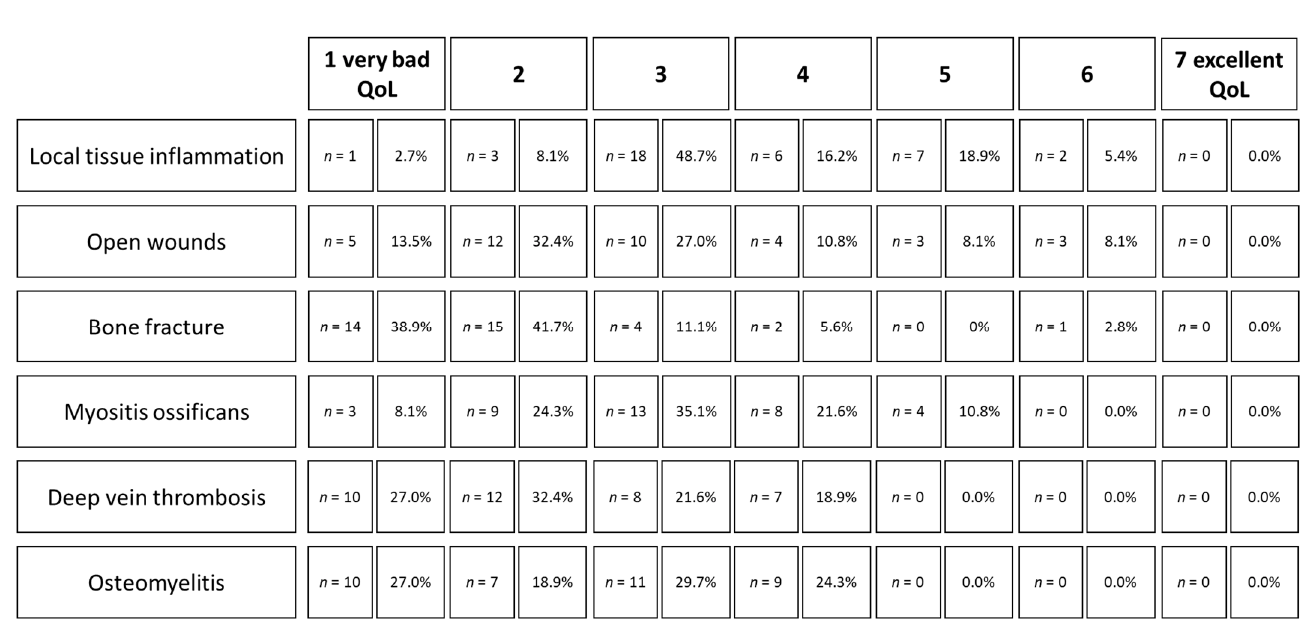
Figure 6. Estimated impact/severity of an adverse event (defined as quality of living; QoL) caused by contraindica- tions/cautions.